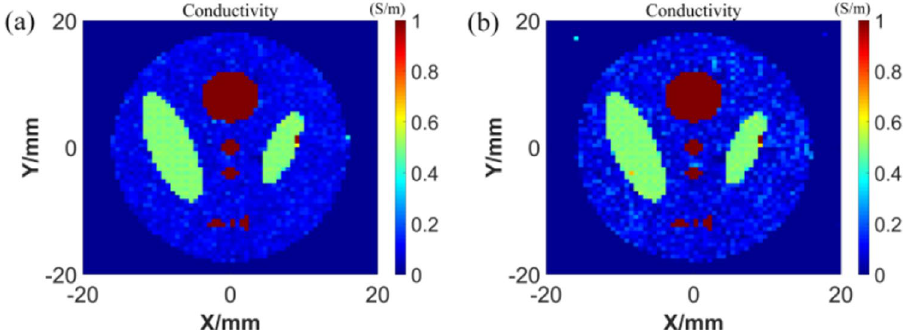
Figure 14. Reconstruction results of conductivity ( a ) SNR = 20 dB ( b ) SNR = 10 dB.